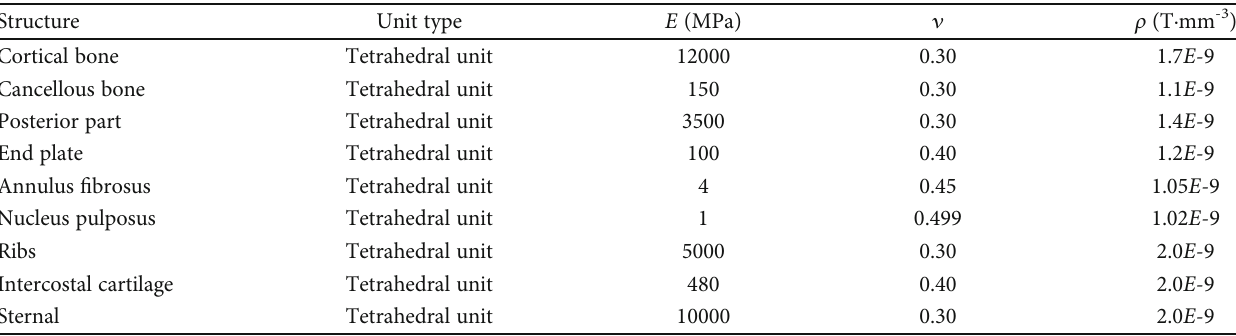
Figure 2: The mesh of vertebral bodies and intervertebral discs are shown: (a) cortical bone; (b) cancellous bone; (c) vertebra; (d) annulus fi brosus; (e) nucleus pulposus; (f) upper and lower endplates; (g) spinal Table 1: The material attributes of various spine structures.